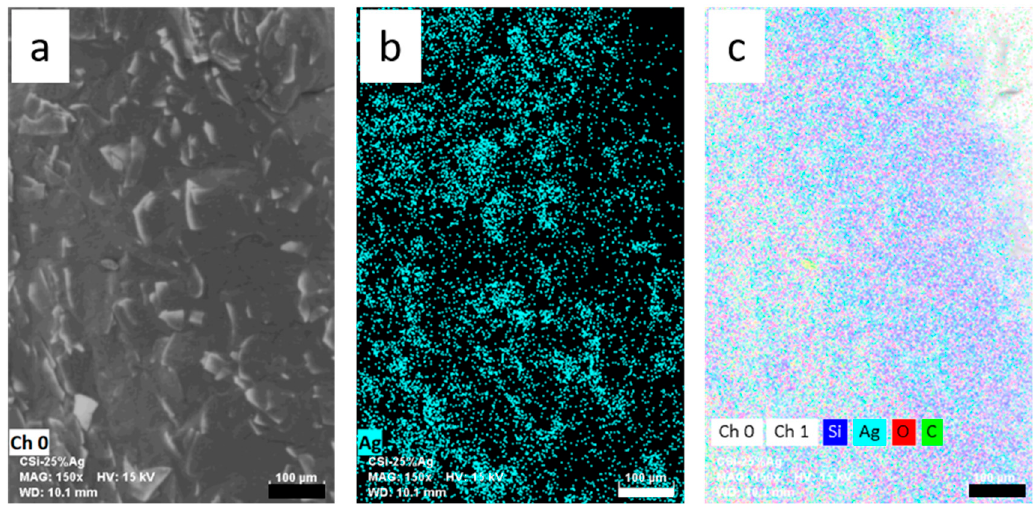
Figure 5. EDX mapping of Ag32000_25%; ( a ) SEM image; ( b ) Ag; ( c ) superimposed image of all relevant elements and SEM image. Size bar 100 µm.